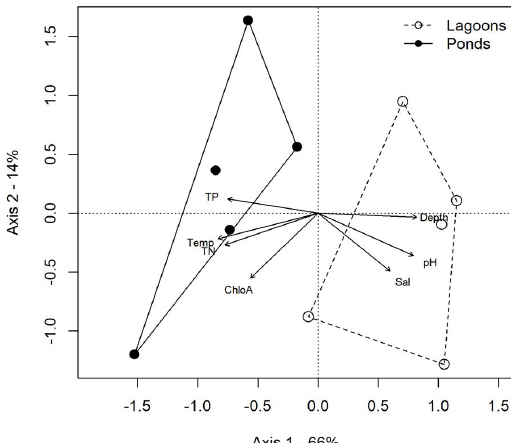
Figure 2. Principal Component Analysis (PCA) using limnological characteristics of temporary ponds and permanent lagoons located in Restinga de Jurubatiba National Park, Rio de Janeiro, Brazil. TP = Total phosphorus; TN = Total nitrogen; ChloA = Chloriphyll a; Temp = Temperature; Sal =